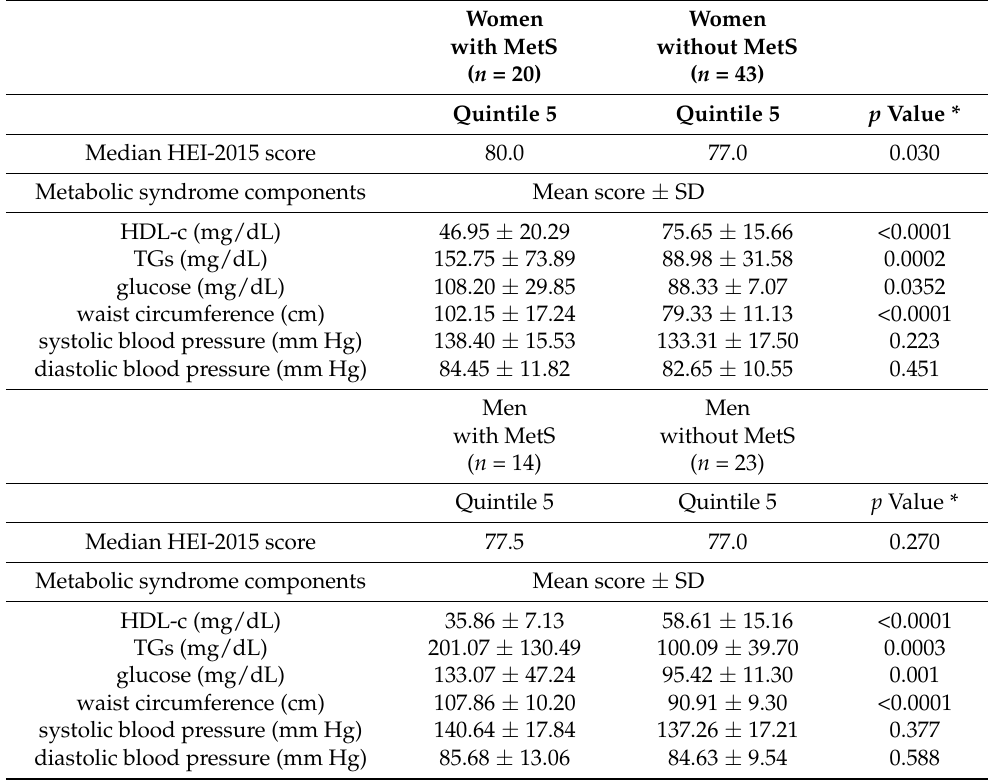
Table 4. Mean metabolic syndrome components for women and men with and without MetS in the fifth quintile of HEI-2015 total